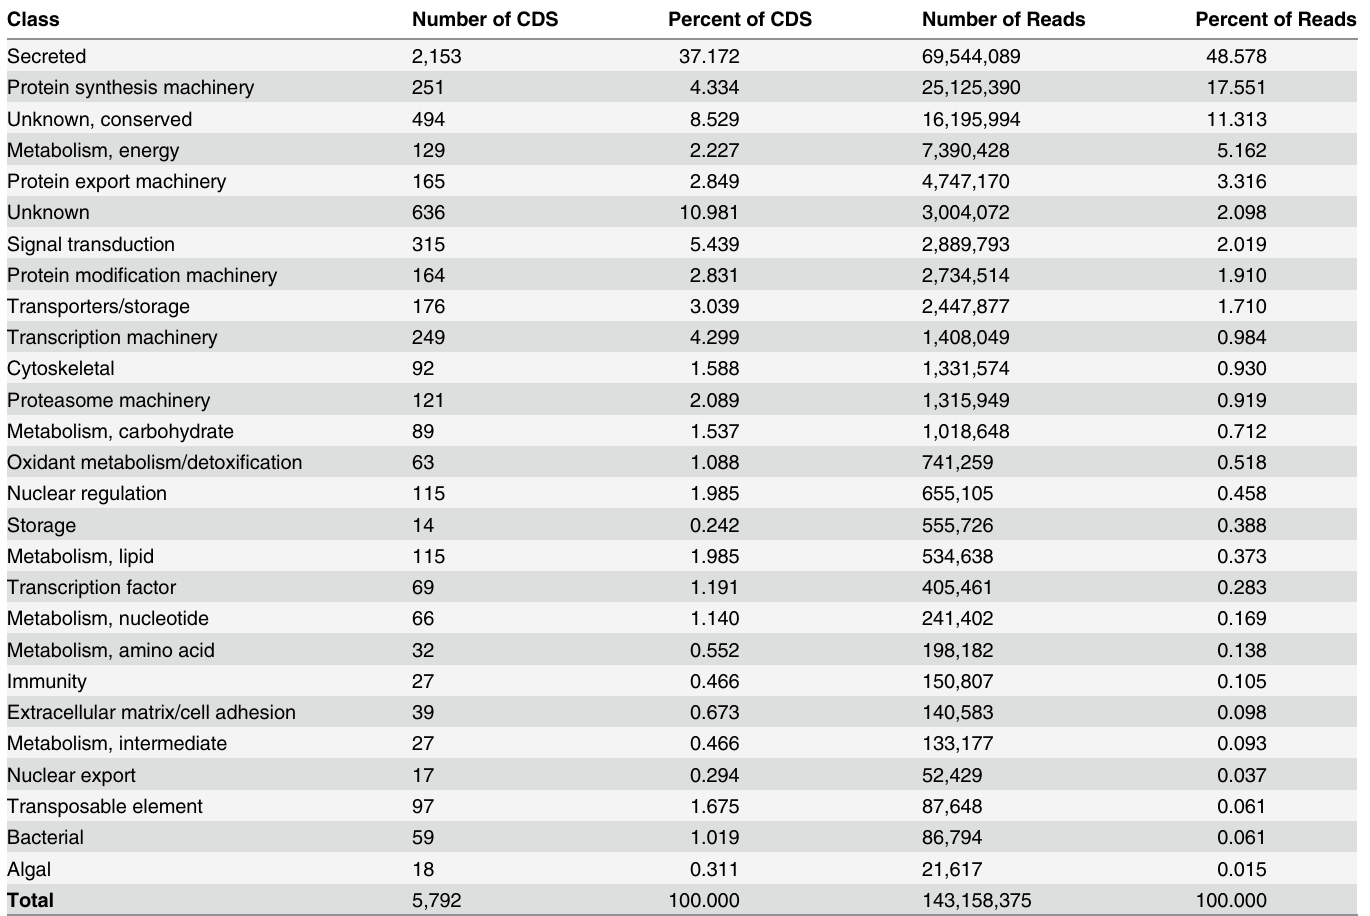
Table 1. Functional classification and associated mapped reads deriving from the sialotranscriptome of Amblyomma americanum